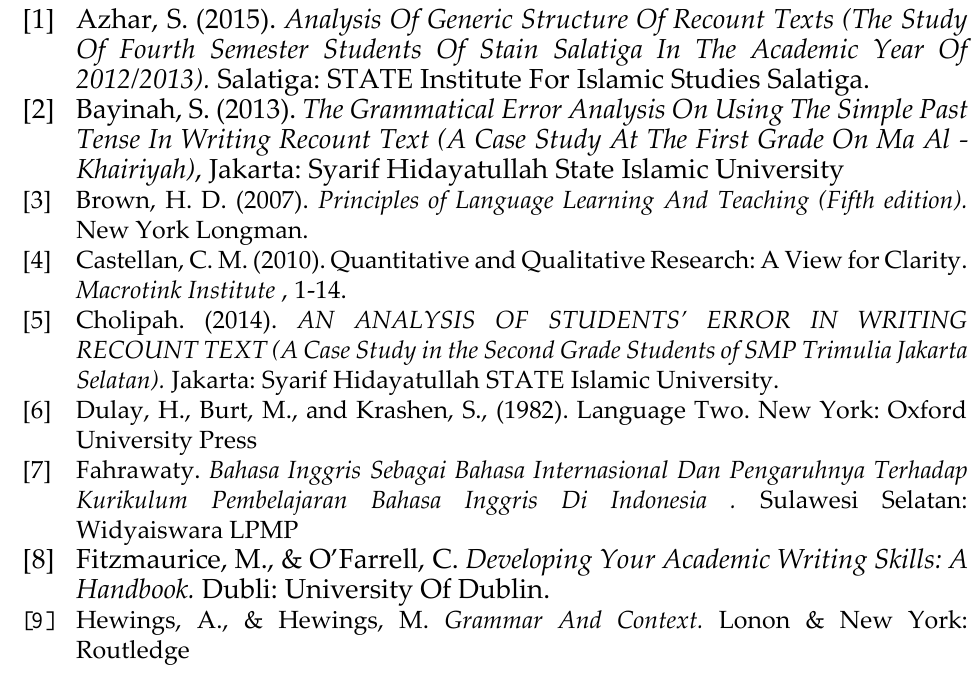
Figure 4.6. Percentage of Students' Source of